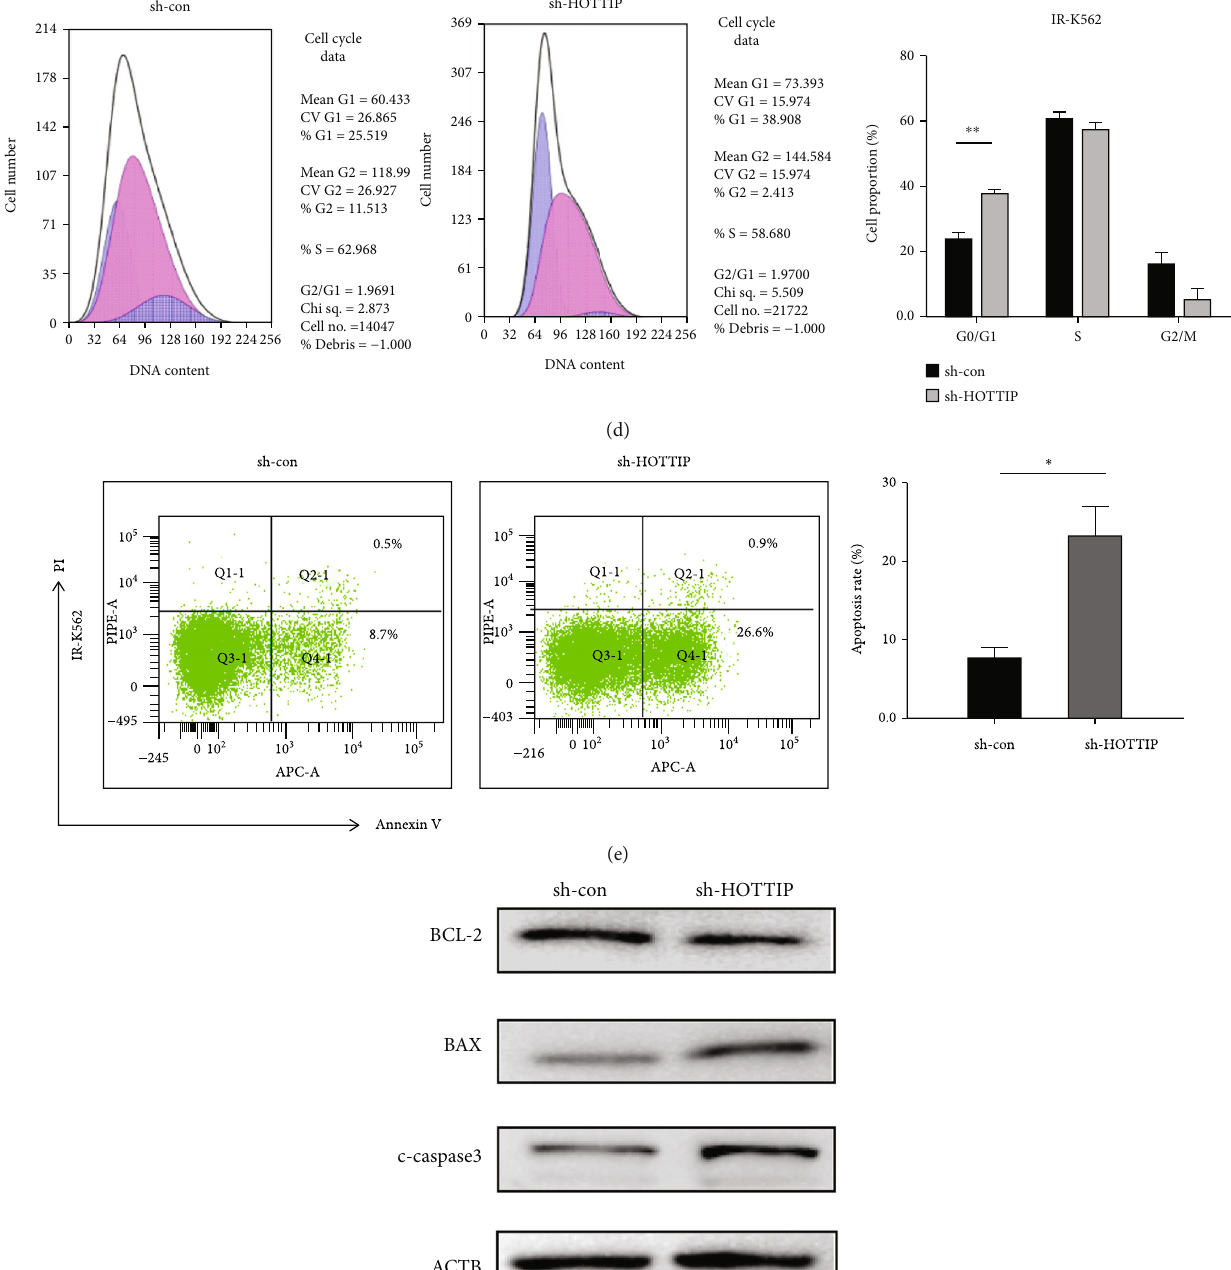
Figure 2: (a) IR-K562 was transfected with speci fi c sh-RNA of HOTTIP or negative. Note: sh-RNA (sh-con). RT-qPCR was used to detect HOTTIP level. (b) IR-K562 was transfected with speci fi c sh-RNA of HOTTIP or negative sh-RNA (sh-con). CCK-8 analysis was used to detect cell proliferation. (c) CML cells were prepared as (a), and cell proliferation was detected by colony formation assay. ∗∗ p < 0 : 01 vs. sh-con. (d) CML cells were prepared as (a), and cell apoptosis rate was detected by fl ow cytometry using Annexin V-APC/PI staining. The right panel shows the apoptosis rate from three independent experiments. ∗ p < 0 : 05 , ∗∗ p < 0 : 01 vs. sh-con. (e) Western blotting for protein levels in IR-K562 cells transfected with sh-HOTTIP and